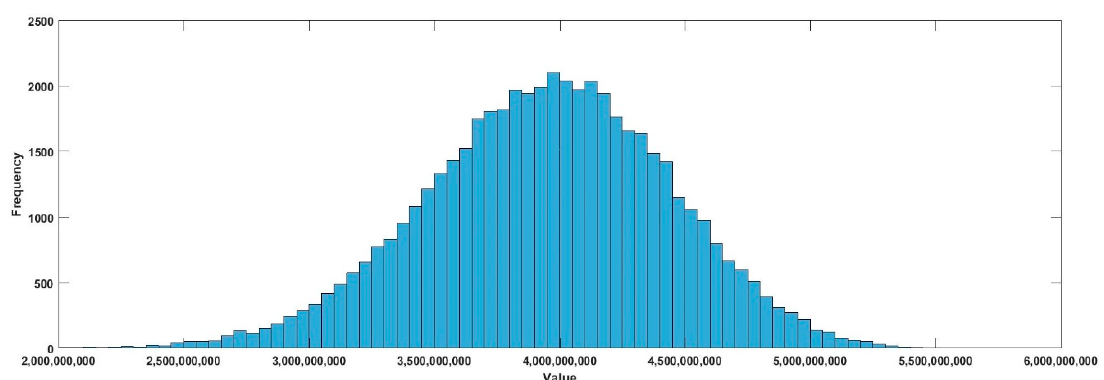
Figure 5. Histogram of the objective function at ε T = 1.1 for the technosociety / high value case with υ = 0.